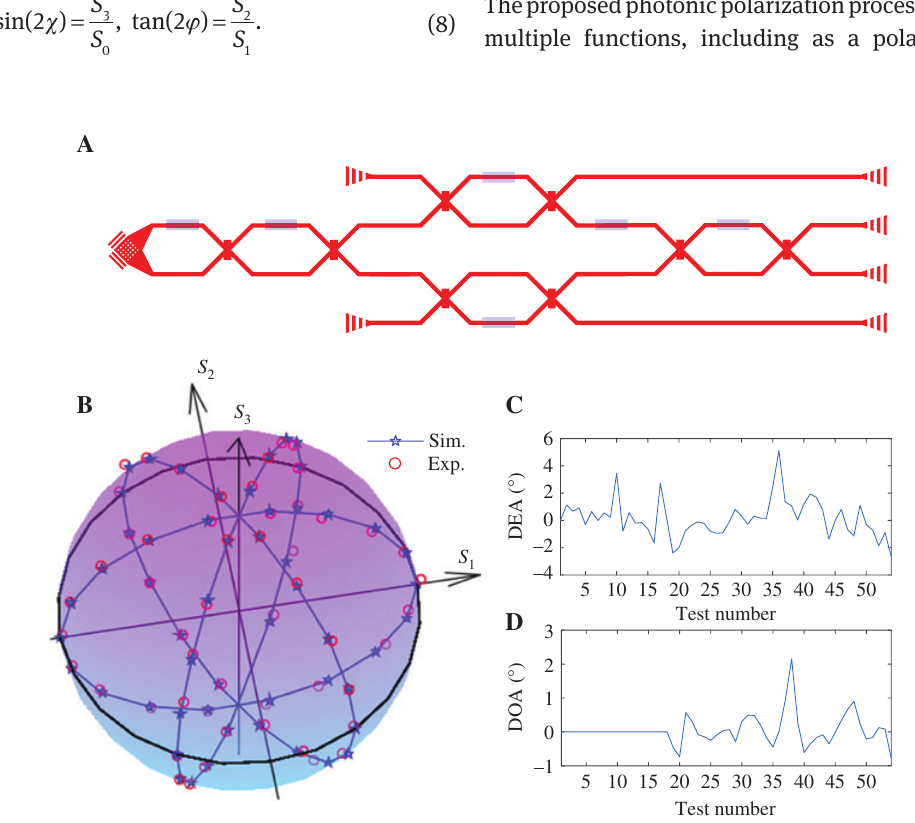
Figure 6: Experimental results for a division-of-space polarization analyzer. (A) Used structure. (B) Experimental Stokes parameters compared with the theoretical results. (C) Deviations of the ellipticity angle. (D) Deviations of the orientation